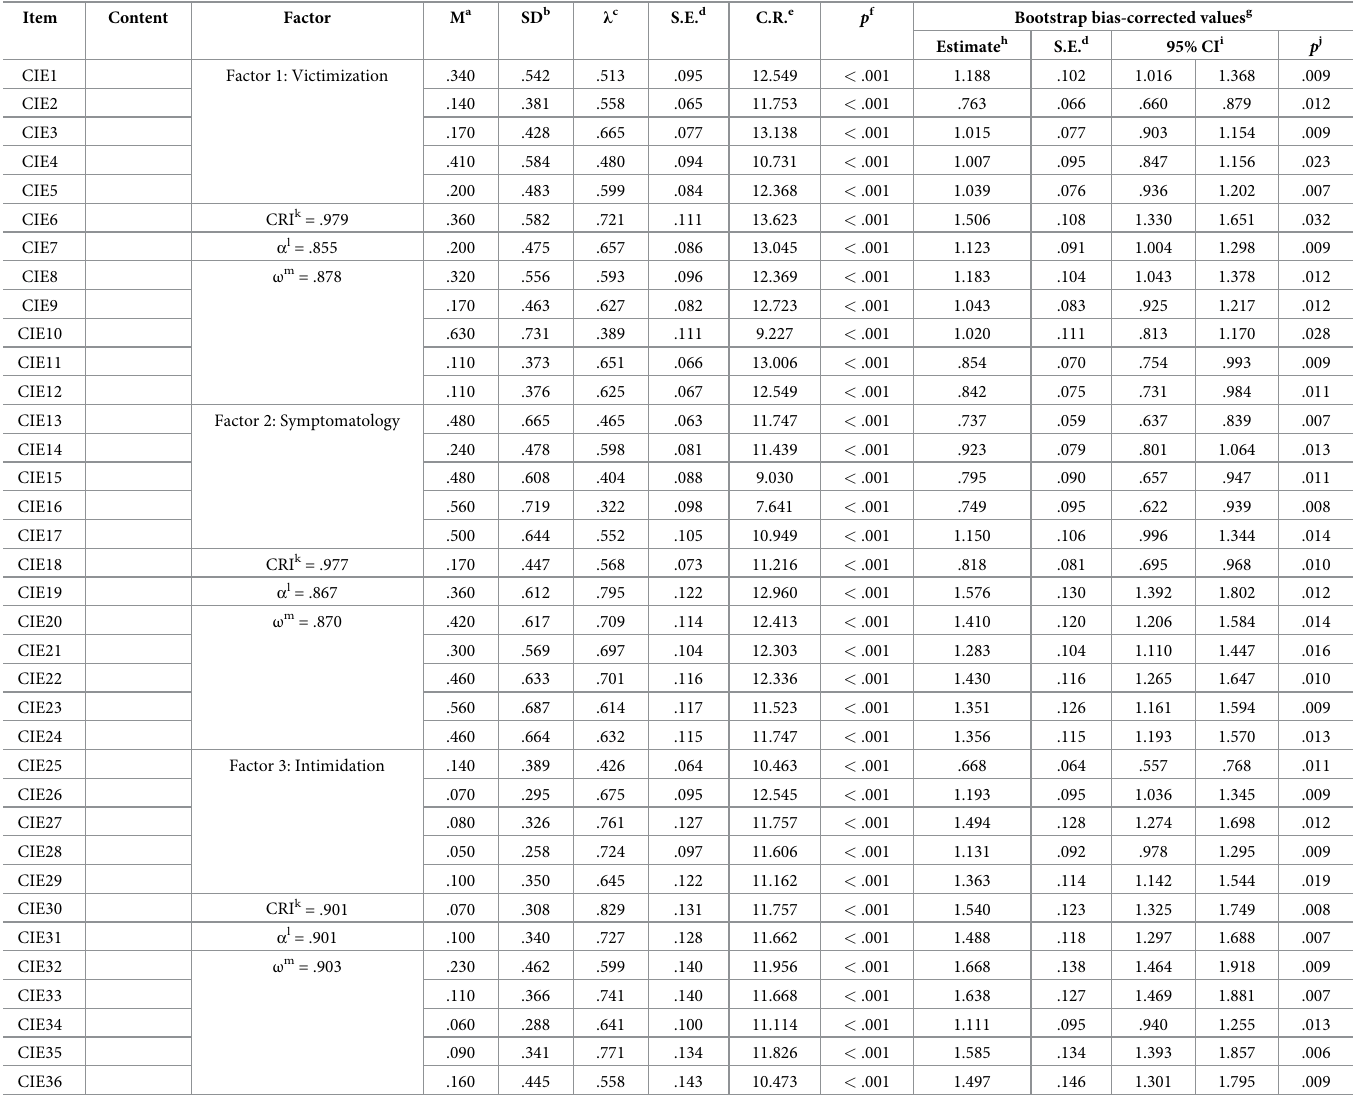
Table 3. Item descriptive—factorial composition and bootstrapped bias-corrected coefficients of the retained three-factor model for the CIE-A. Item Content